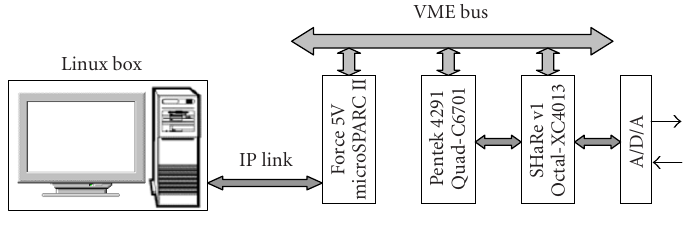
Figure 4: Integrated